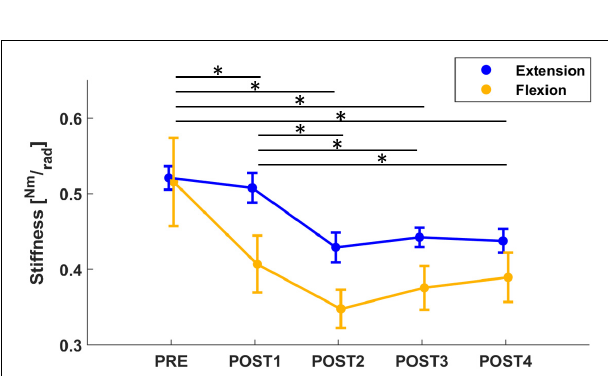
FIGURE 3 | The mean and standard error of wrist stiffness, calculated in both flexion (yellow) and extension (blue) directions. Stiffness significantly decreased from PRE to all post-fatigue assessment sessions, showing a more significant decrease in flexion than extension direction. Significant results ( p < 0.05), after post-hoc analysis, were marked with “ ∗